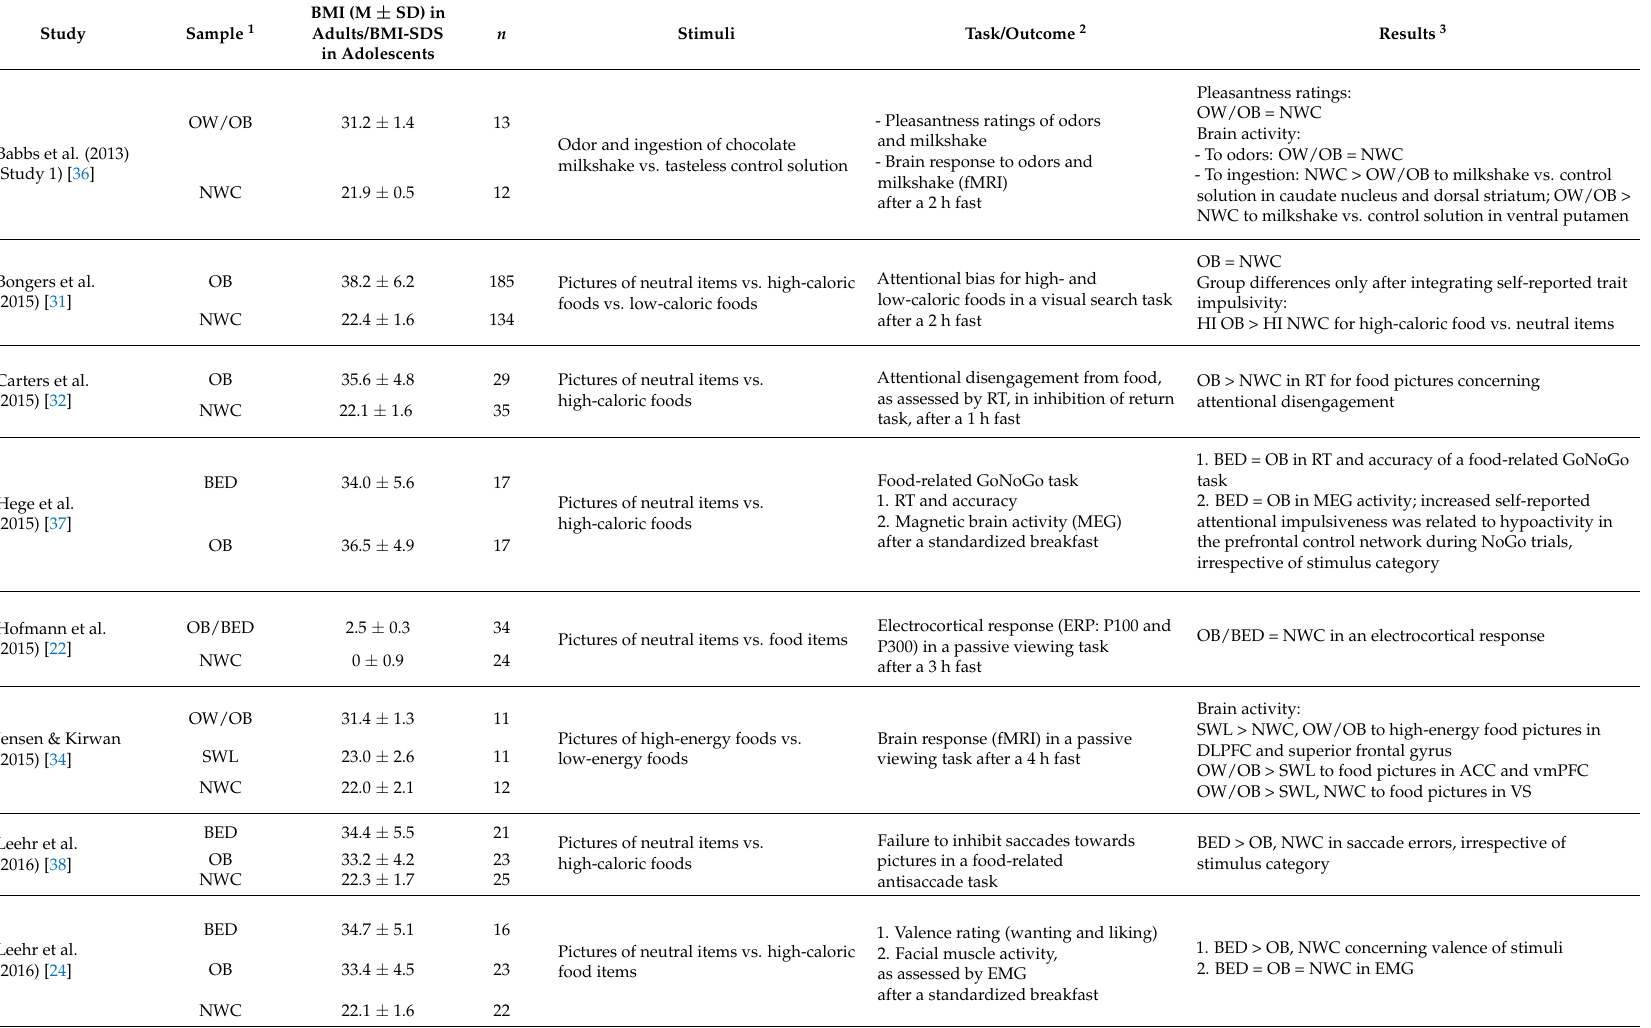
Table 1. Experimental studies investigating food-related